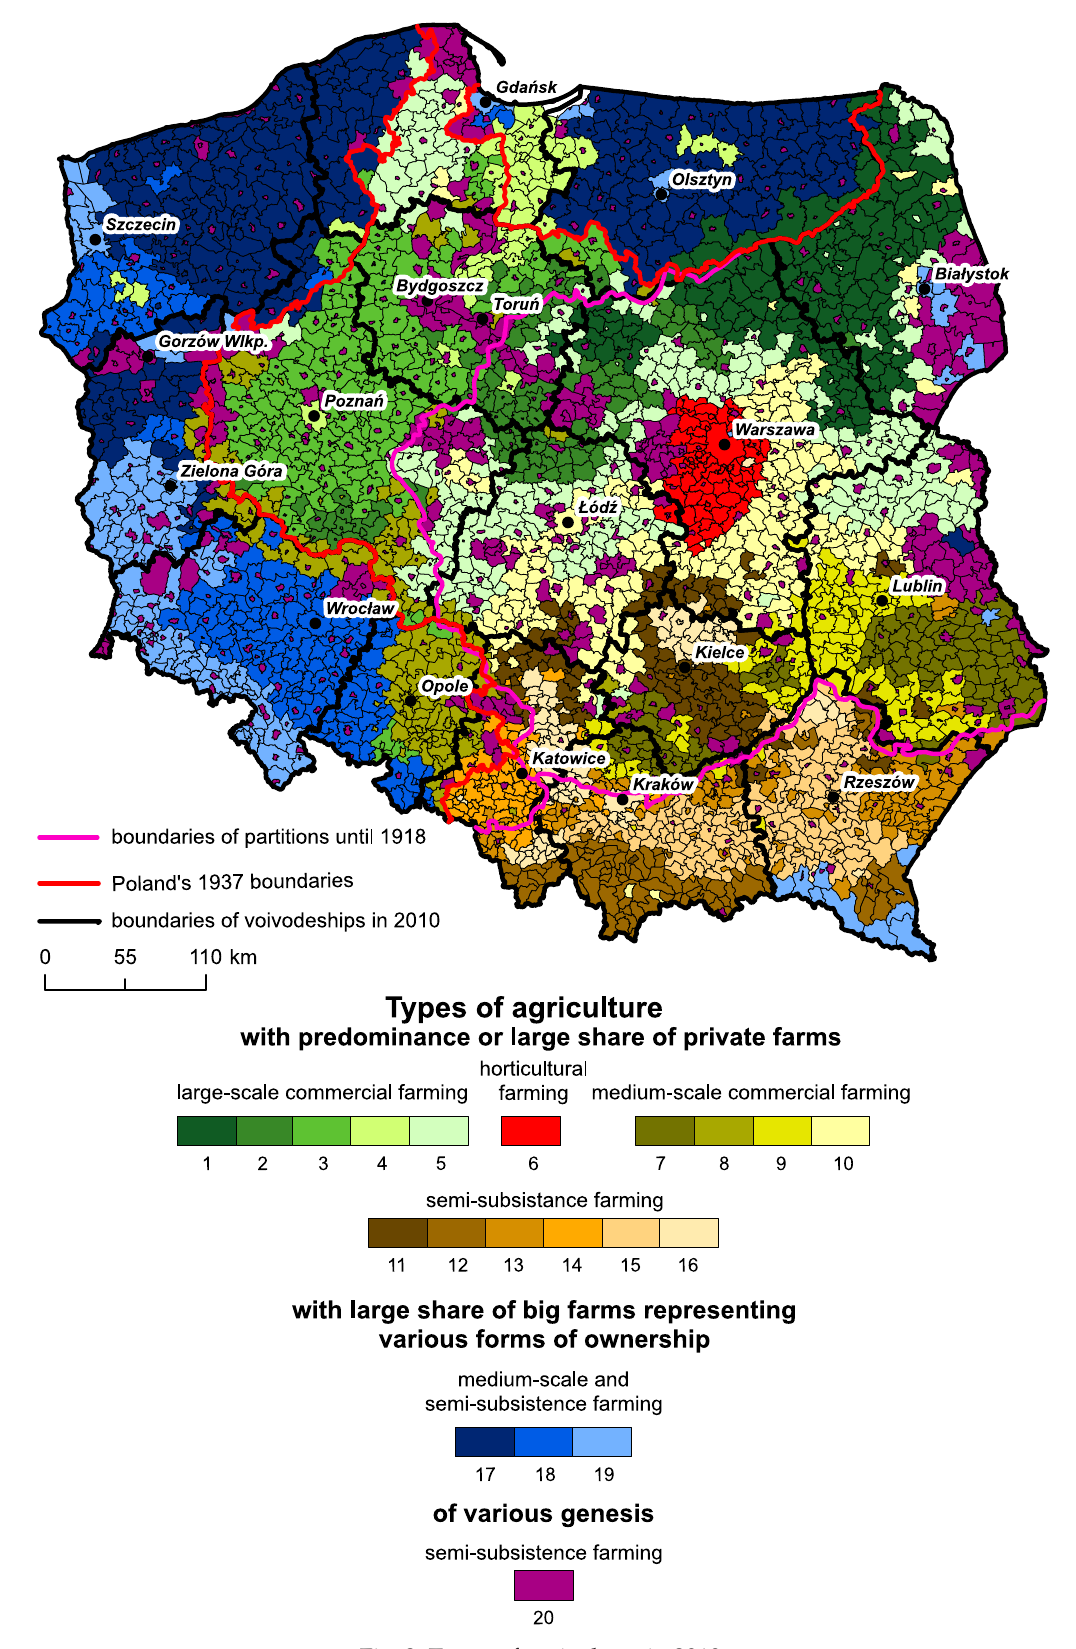
Fig. 3. Types of agriculture in 2010. Source: own